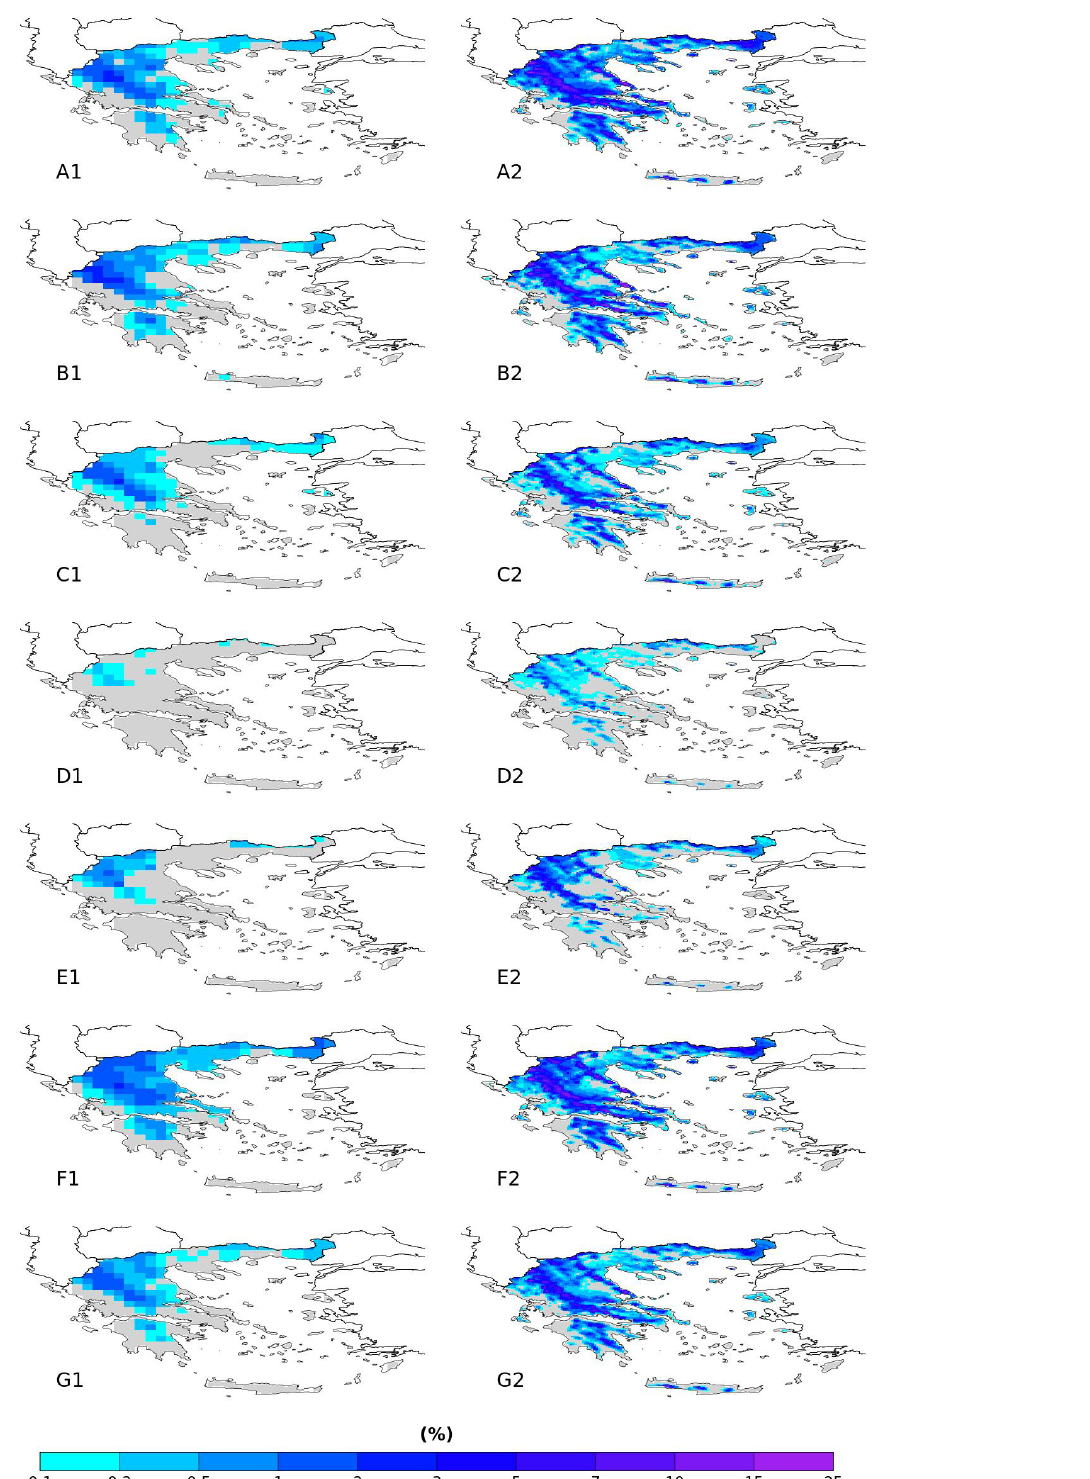
Figure 3. WCCEs probabilities spatial distribution for (1) ERA5 and (2) WRF_5 for the months (a) January, (b) February, (c) March, (d) April, (e) November, (f) December and (g) for the entire season November–April.